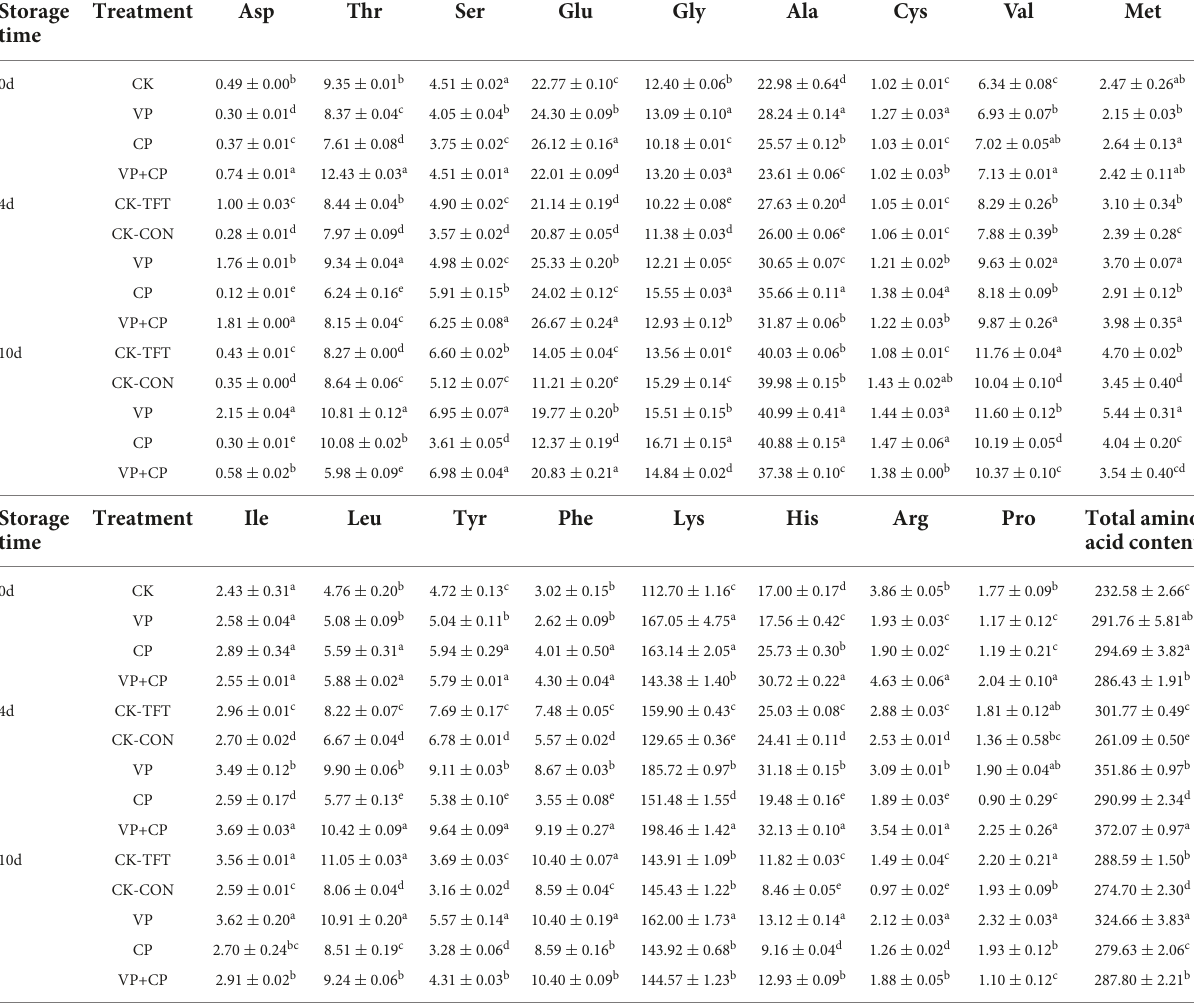
TABLE 2 Effects of different treatments on free amino acid content (mg / 100 g) of salmon in cold chain logistics. Storage